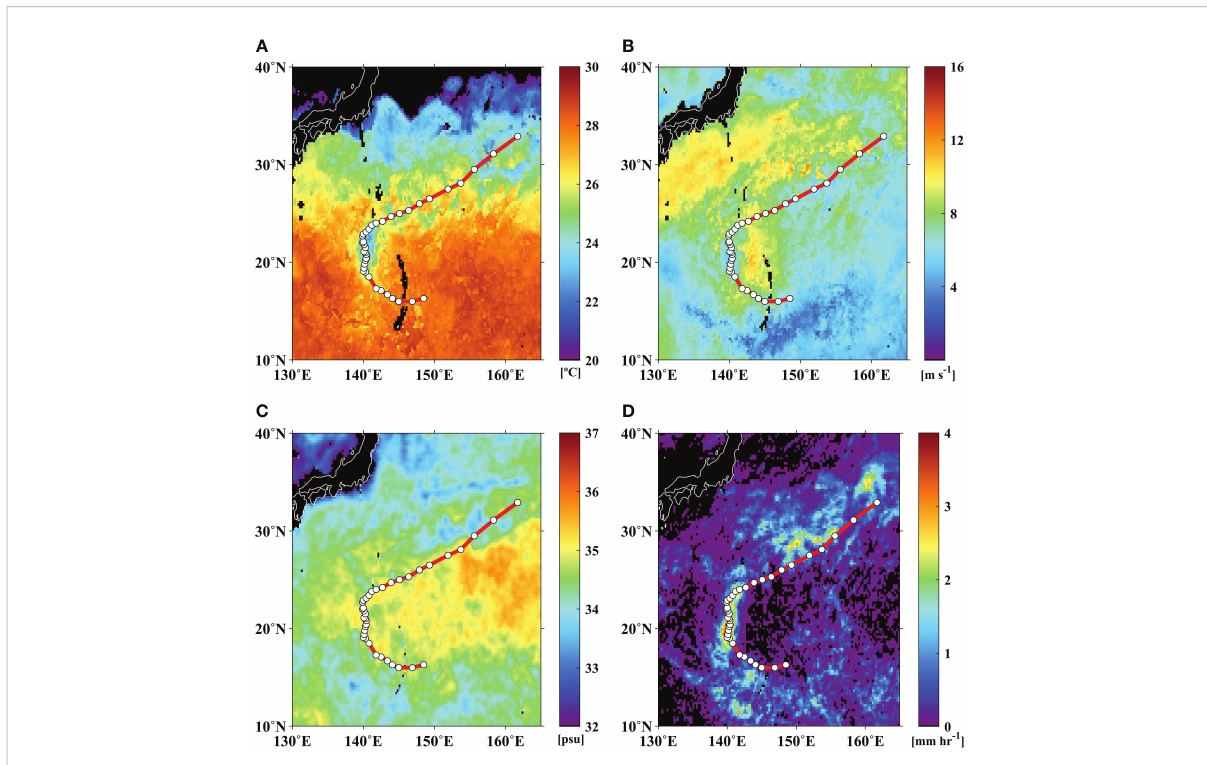
in Figure 12. The SST distribution indicated spatially differential cooling on the right sides of 10 typhoons compared to the left sides (Figure 12A), which is consistent with previous studies (Cornillon et al., 1987; Sakaida et al., 1988; Wada, 2005; Jiang et al., 2006), The mean Aquarius SST of 10 typhoons on the right side was approximately 26.8°C at distances of 0 – 300 km from the typhoon center, which was in contrast to the high SST of